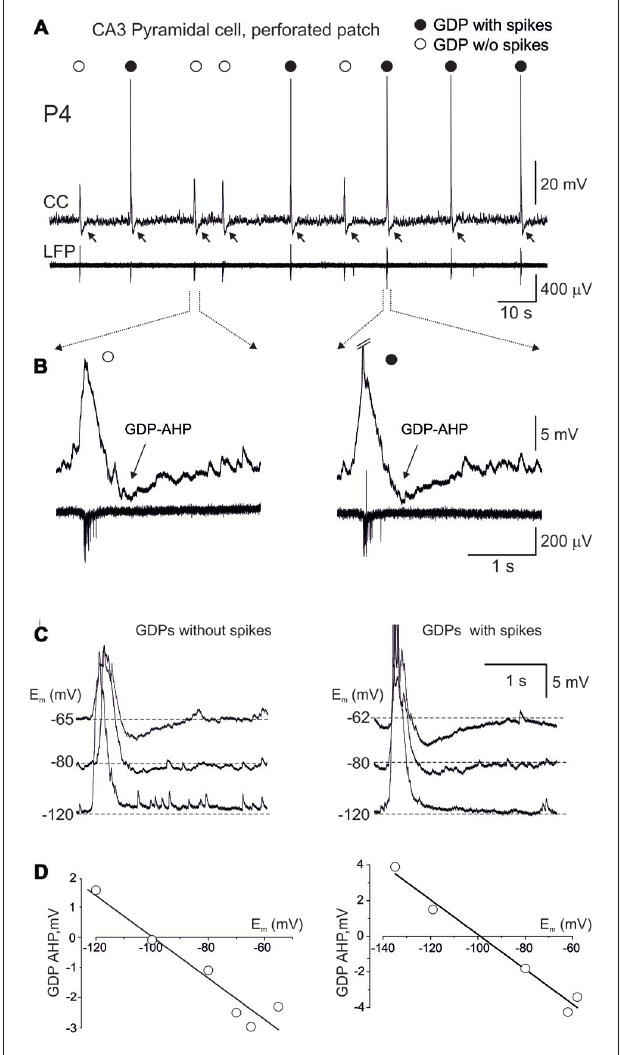
FIGURE 1 | Terminating Giant Depolarizing Potentials (GDPs) afterhyperpolarization (AHP) is expressed in CA3 pyramidal cell independently of whether the cell fires or not during GDP. (A) Example traces of gramicidin perforated patch recordings in current-clamp mode (CC) from a CA3 pyramidal cell and local field potential recordings (LFP) from the CA3 pyramidal cell layer. Note that the cell fires (black circles) or not (open circles) during GDPs. Independently of whether cell fires or not during GDPs, GDPs are followed by AHP (GDP-AHP, marked by arrows). (B) Examples of GDPs during which the cell remains silent (left) or fires (right, spikes are truncated) during GDPs on expanded time scale. Note that GDP-AHP is expressed independently of whether the cell is activated or not during GDP. (C) Example traces of GDPs in current clamp mode at different values of the membrane potential maintained through an injection of the negative current. Left, GDPs without spikes and right, GDPs with spikes. Spikes are truncated. (D) Corresponding plots of the GDP-AHP amplitude as a function of the membrane potential. Note that the GDP-AHP reverses at around the potassium reversal